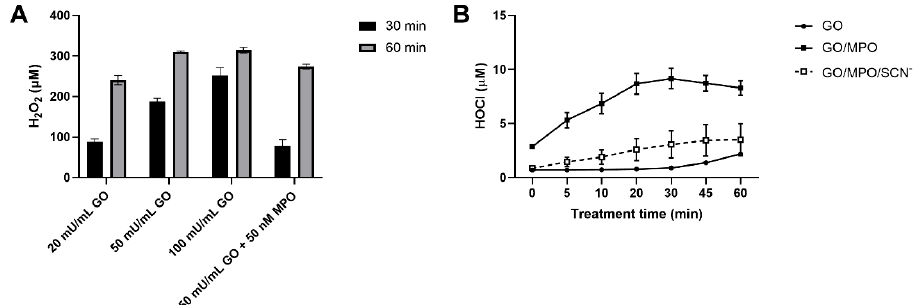
Figure 2. The production of H 2 O 2 and HOCl by the GO / MPO enzymatic system. ( A ) The formation of H 2 O 2 was assessed using the Amplex Red reagent (100 µM Amplex Red and 0.2 U mL -1 HRP) in reaction mixtures containing GO (20, 50, and 100 mU mL − 1 ) in complete HBSS after 30 and 60 min by measuring resourfin fluorescence at λ ex 571 nm and λ em 585 nm. Samples containing GO (50 mU mL − 1 ) and MPO (50 nM) were also examined. ( B ) HOCl was assessed using the R19-S probe (250 µM) in reaction mixtures containing GO (50 mU mL − 1 ) and MPO (50 nM) in the absence and presence of SCN − (200 µM) in HBSS containing glucose (5.6 mM). Fluorescence was measured using λ ex 515 nm and λ em 550 nm at different time points (0–60 min), with GO (circle, solid line), GO/MPO (solid symbol, solid line), and GO/MPO/SCN − (open square, dashed line). Data represent mean ± S.E.M from three independent experiments.